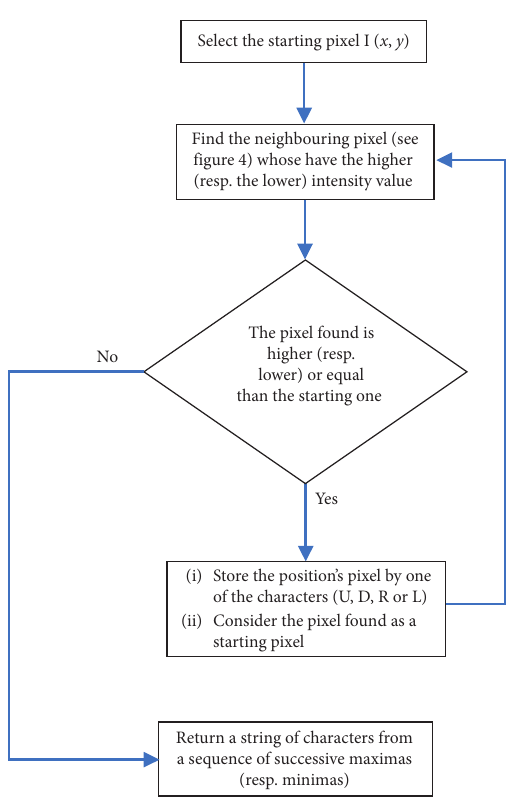
Figure 5: Process of finding strings from a pixel in the face image.